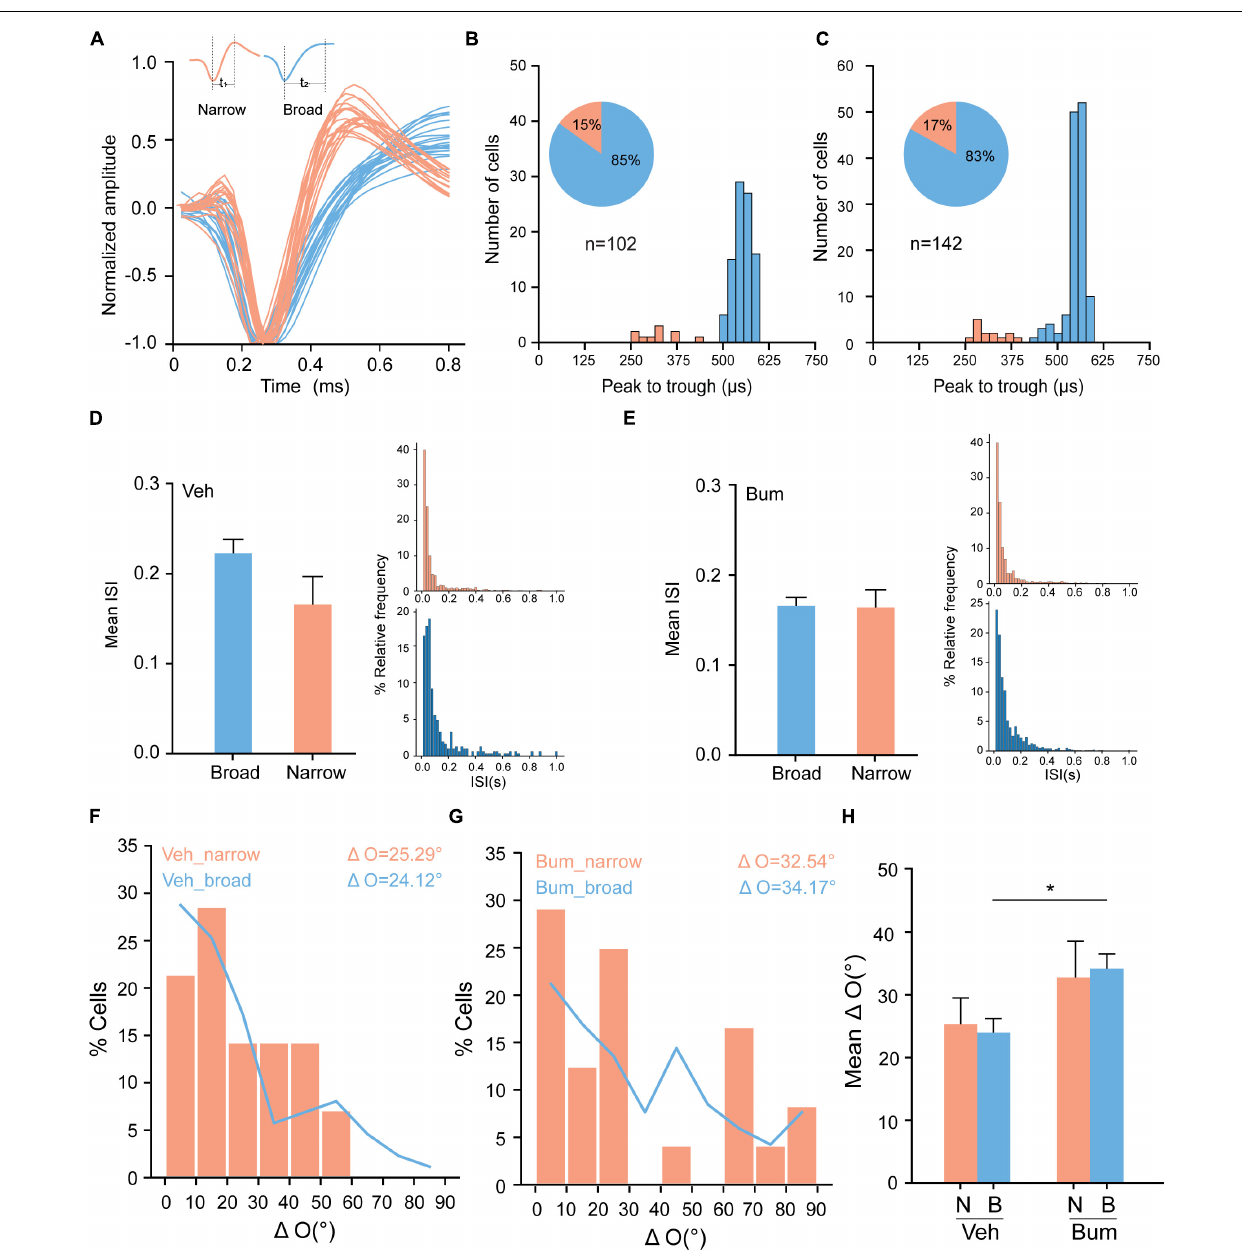
FIGURE 5 | Bum treatment causes binocular mismatching of broad neurons. (A) Isolated units were classified as excitatory or inhibitory based on characteristics of their waveform. Example trace (20 spikes) from two units, one classified as putative inhibitory (orange) and one as putative excitatory (blue). (B,C) Distribution of peak to trough time of spike waveforms in Veh and Bum mice. In total, ∼ 15% of the units in both groups were classified as putative inhibitory (15%, 15 of 122; 17%, 24 of 142 units from Veh and Bum animals, respectively). (D) Left, mean inter-spike interval (ISI) of broad and narrow neurons for Veh mice at P35. Right, the ISI distribution for narrow (top) and broad (bottom) unit sample, the data were binned at 20 ms from 0 to 1 s. (E) The same as for (D) in Bum mice at P35. (F,G) Distribution of interocular difference of preferred orientation (“ (cid:49) O”) in both narrow and broad neurons of Veh and Bum groups: (F) Veh mice (narrow: (cid:49) O = 25.29 ± 4.07 ◦ , 15 cells, nine mice; broad: (cid:49) O = 24.26 ± 2.21 ◦ , 87 cells). (G) Bum mice (narrow: (cid:49) O = 32.54 ± 5.7 ◦ , 24 cells, 14 mice; broad: (cid:49) O = 34.17 ± 2.32 ◦ , 118 cells). (H) Mean (cid:49) O of narrow and broad neurons in both Veh and Bum animals ( p = 0.0151, Veh_broad vs. Bum_broad; p = 0.772, Veh_narrow vs. Bum_narrow; One-way ANOVA with Tukey’s post hoc test). N: Narrow, clear orange: Broad, pale blue). Data were expressed as mean ± SEM. * p <